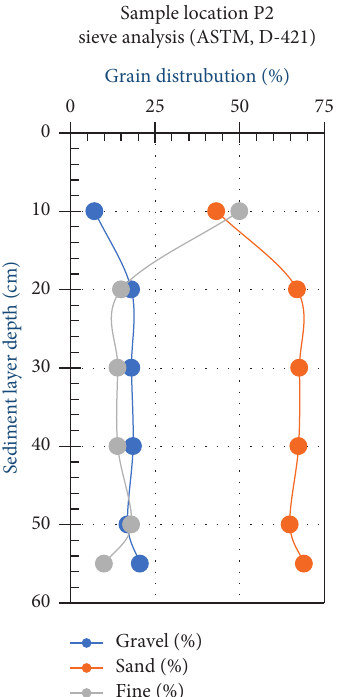
Figure 4: Sieve analysis ratio of the sediment soil types along with the core depth.